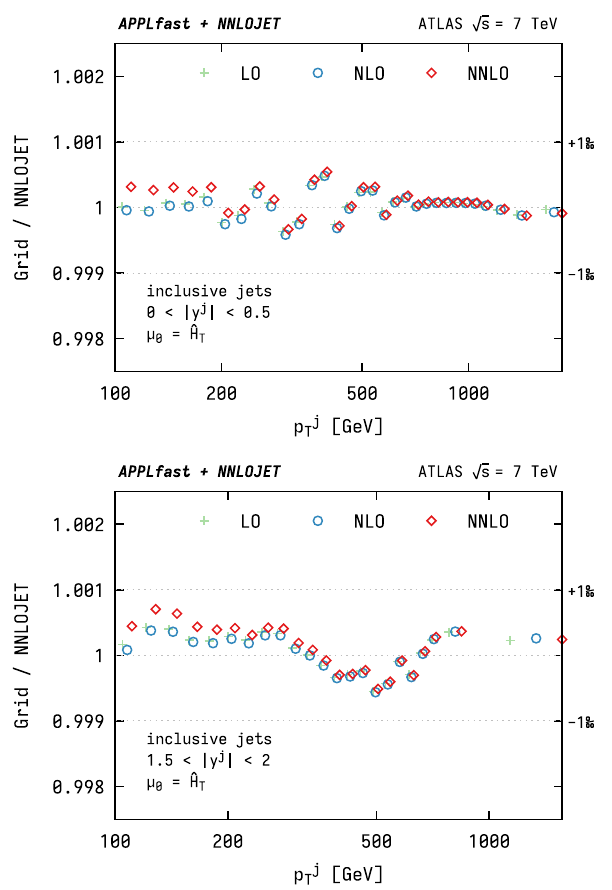
Fig. 1 Closure tests for the ATLAS 7TeV inclusive jet cross section grid as a function of p jet for two representative ranges in rapidity. The T horizontal dotted lines indicate the targeted closure of one